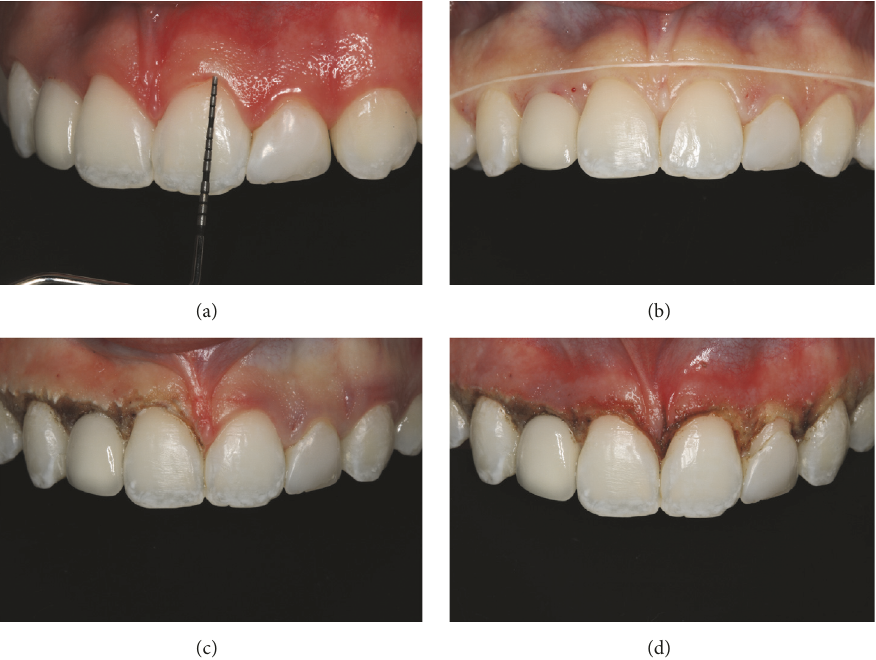
Figure 4: Probing after the scaling and prophylaxis sessions, performed prior to the surgical treatment (a). The smile line was marked with dental floss (b). Gingival recontour with an electric scalpel on the right side (c). Appearance immediately after gingival recontour (d).